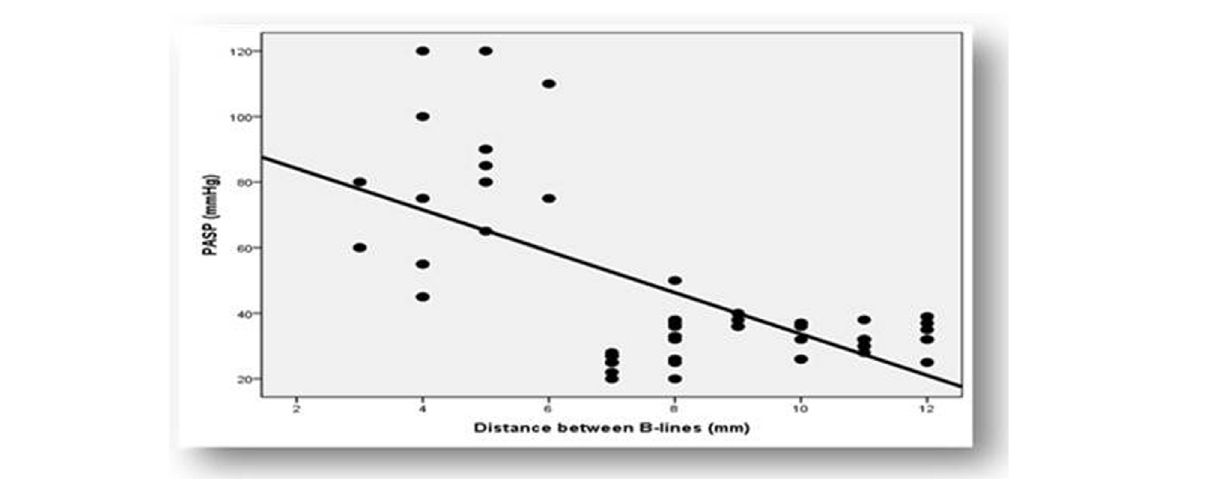
The relation between B-line distance and pulmonary artery systolic pressure (PASP).